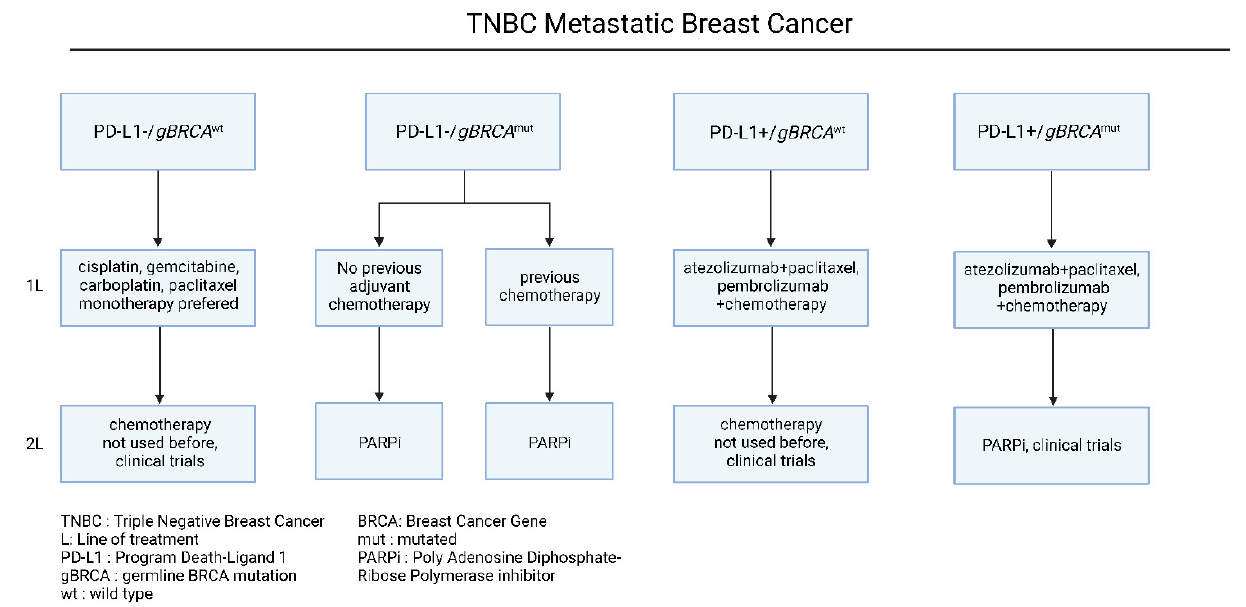
Figure 5. Current therapeutic algorithm for the management of TNBC mBC. Proposed therapeutic algorithm for patients with Triple Negative metastatic breast cancer [79,80]. The abbreviations of the terms used in the figure are outlined in the lower part of the algorithm.